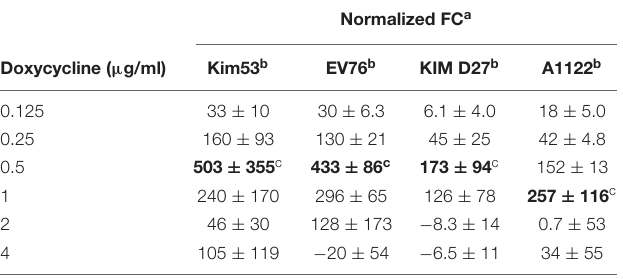
TABLE 3 | Molecular MIC analysis of Y. pestis strains.